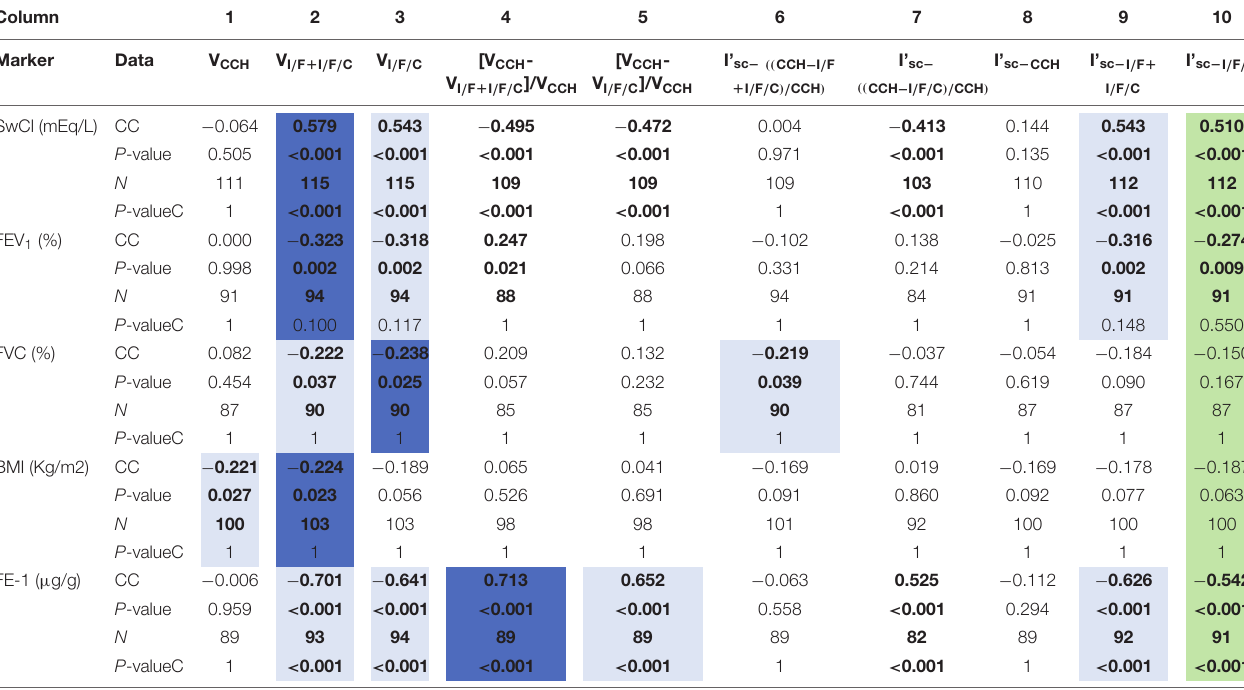
TABLE 1 | Correlation of electrophysiological parameters obtained from Ussing chamber measurements in rectal biopsies with CF biomarkers and clinical CF features. Column